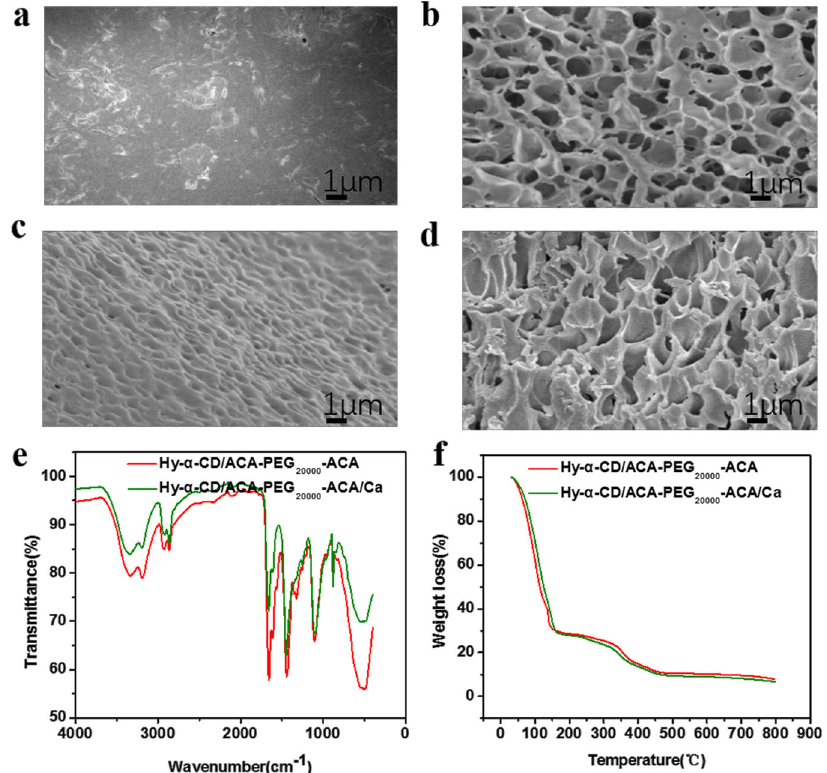
Fig. 2 SEM images, FT-IR spectra characterization and thermogravimetric analysis of hydrogels. a Surface SEM image of Hy- α -CD/ACA-PEG 20000 -ACA hydrogel. b Cross-sectional SEM image of Hy- α -CD/ACA-PEG 20000 -ACA hydrogel. c Surface SEM image of hydrogel doped with CaCl 2 . d Cross-sectional SEM image of hydrogel doped with CaCl 2 . e The FT-IR spectra of hydrogel (olive, hydrogel doped with CaCl 2 ; red, hydrogel doped without CaCl 2 ). f TG curves of hydrogel (olive, hydrogel doped with CaCl 2 ; red, hydrogel doped without CaCl 2 ).